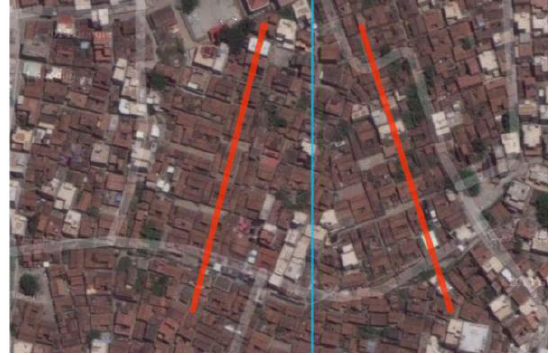
Figure 2. Architectural orientation of residential complexes of the Changs in Tungyuan Village deviates by 5° in the left and